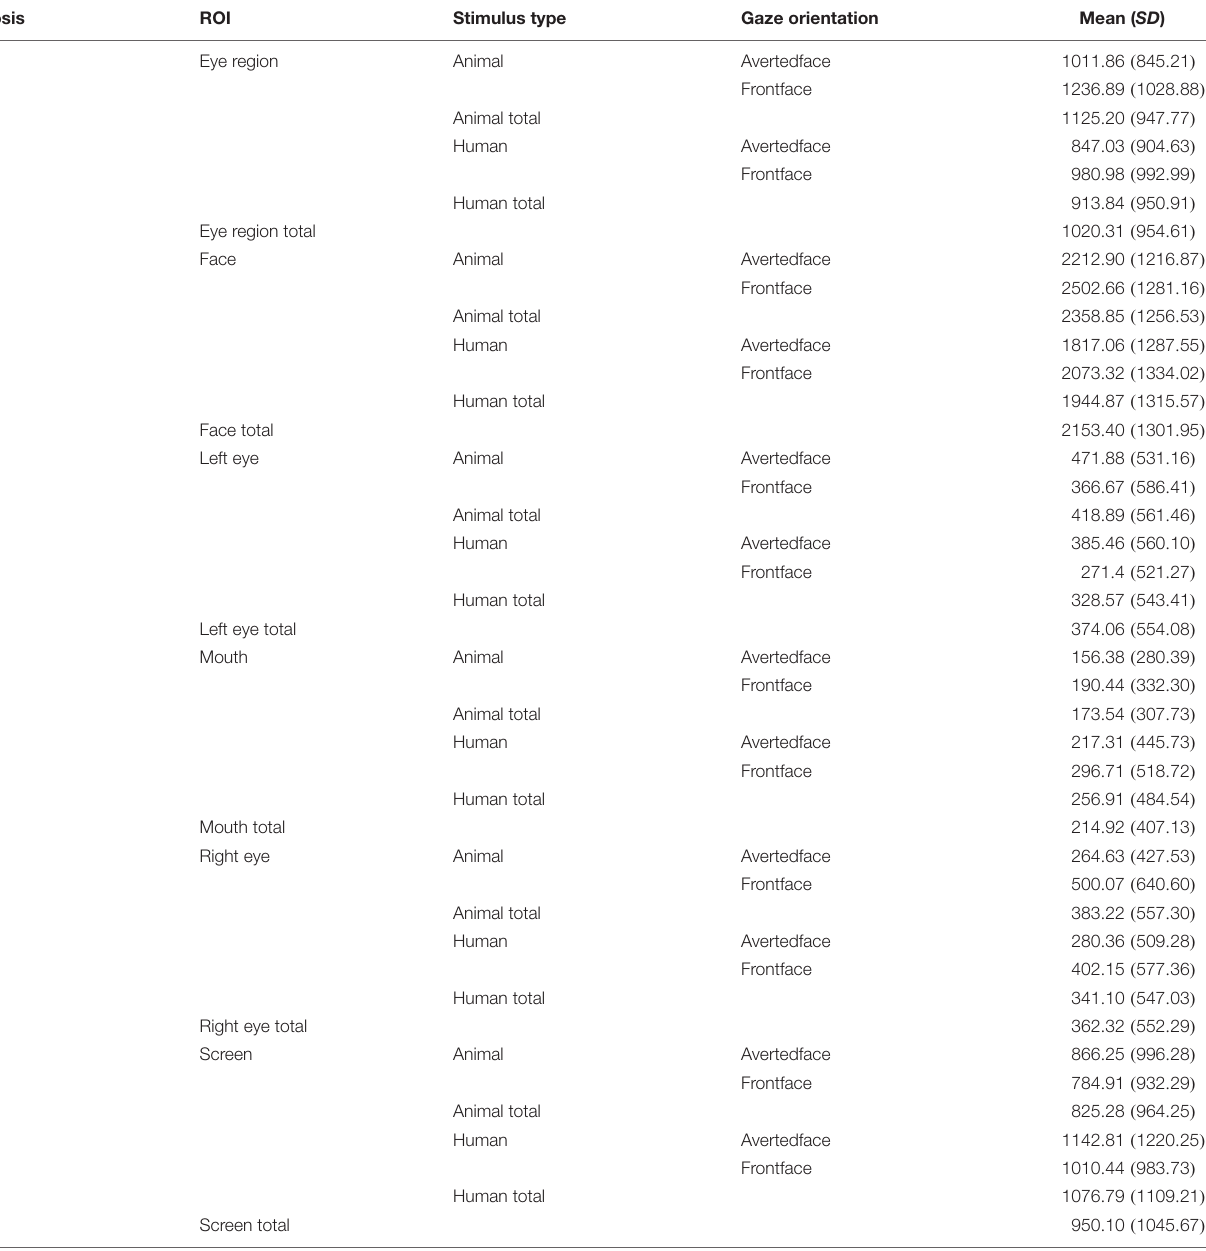
TABLE 2 | Mean and SD values of gaze fixation duration on all ROIs of human and animal images for ASD participants. Diagnosis ROI